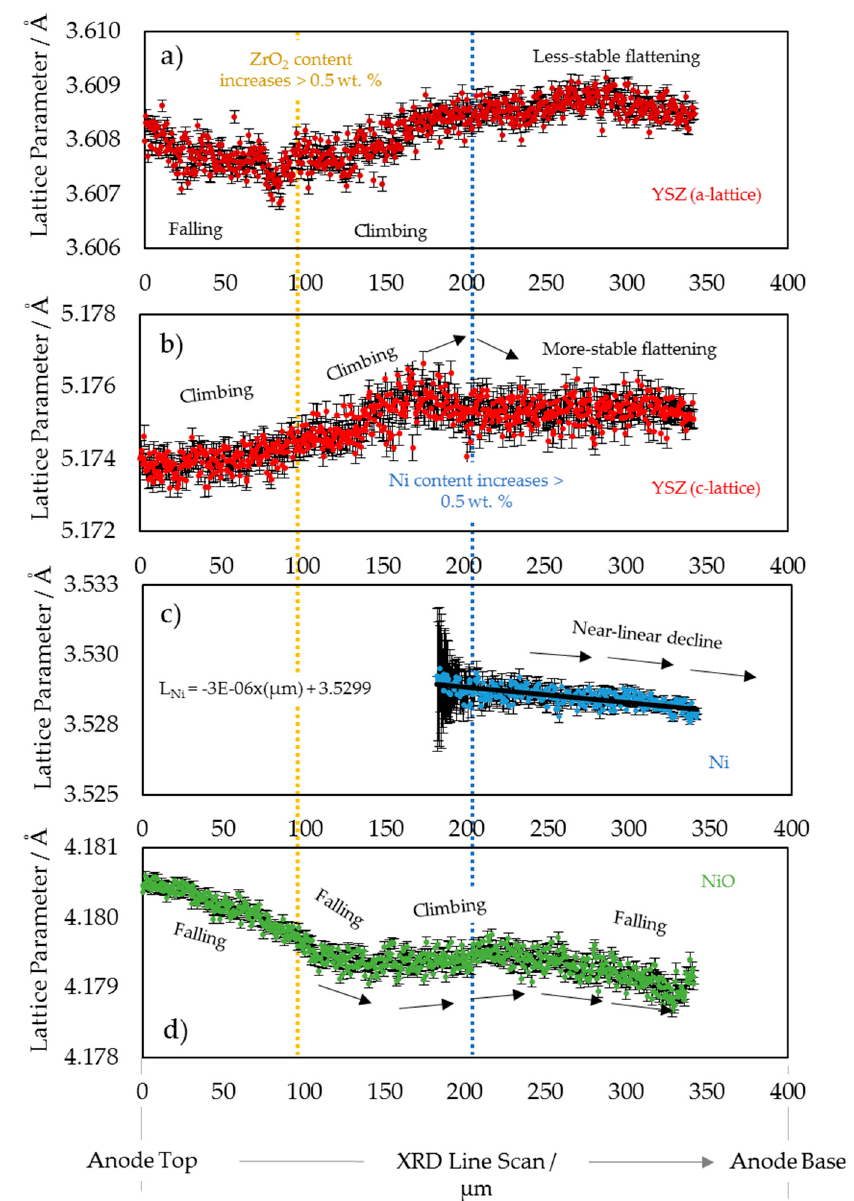
Figure 3. Lattice parameters for the ( a ) YSZ a-lattice (dark red), ( b ) YSZ c-lattice (light red), ( c ) Ni lattice (blue), and ( d ) NiO lattice (green). The data are reported with error bars (black). The introduction of notable amounts (i.e., > 0.5 wt. %) of ZrO 2 (yellow) and Ni (blue) is indicated with dashed vertical lines.